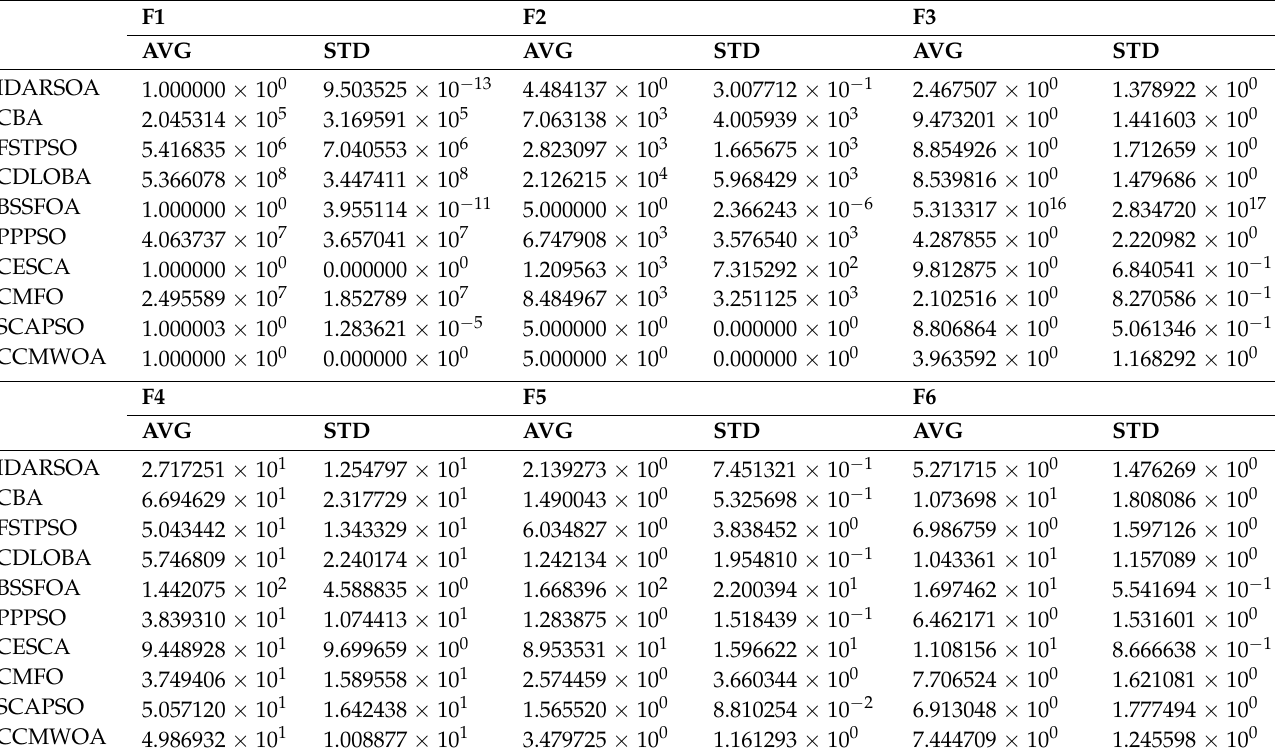
Table 10. Comparison of IDARSOA and other advanced